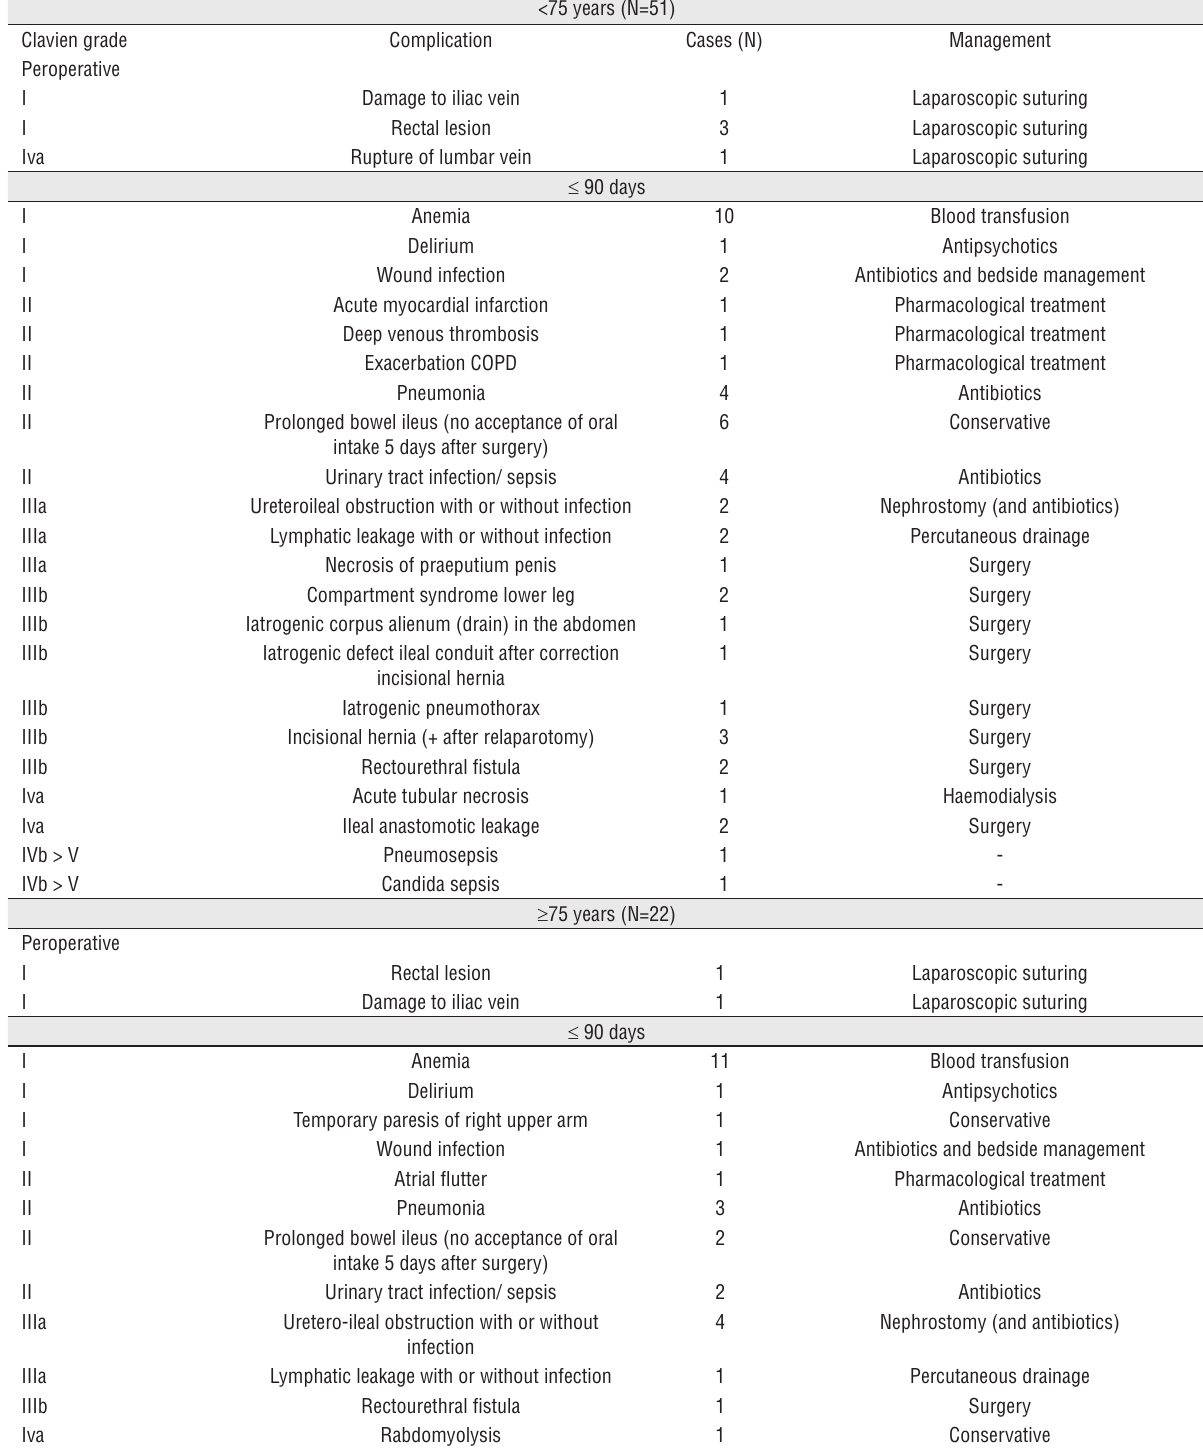
Table 3 - complications within 90 days after laparoscopic radical cystectomy for younger (<75 years) and elderly ( ≥ 75 years) patients according to the modified clavien classification